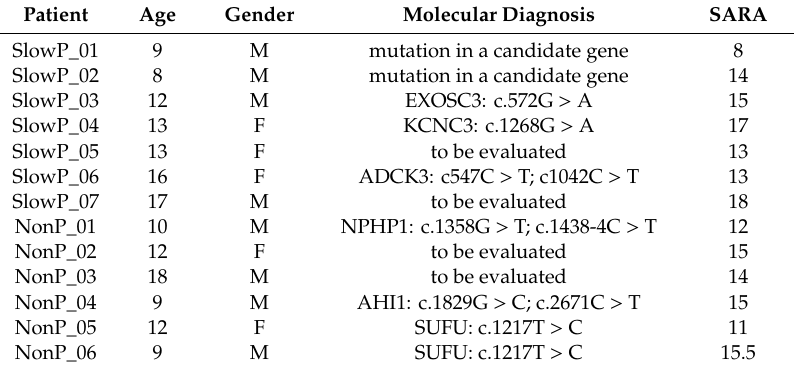
Table 1. Demographic and clinical characteristics of children with PCA. SlowP: slowly progressive ataxia; NonP: non-progressive ataxia (Joubert syndrome); EXOSC3: exosome component 3; KCNC3: potassium voltage-gated channel subfamily C member 3; ADCK3: aarF domain-containing kinase 3; NPHP1: nephrocystin 1; AHI1: Abelson helper integration site 1; SUFU: negative regulator of